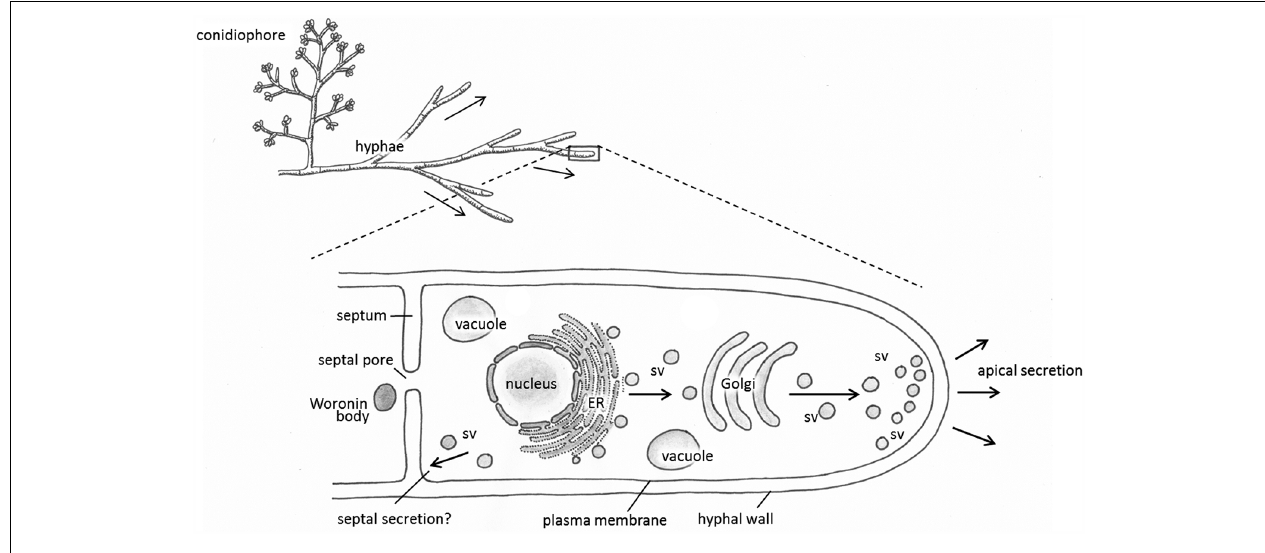
FIGURE 1 | Schematic representations depicting the general morphology of Trichoderma reesei (top) and proposed pathways of protein synthesis and secretion (enlarged hyphal tip, below). Proteins are synthesized in the endoplasmic reticulum (ER), then travel in secretory